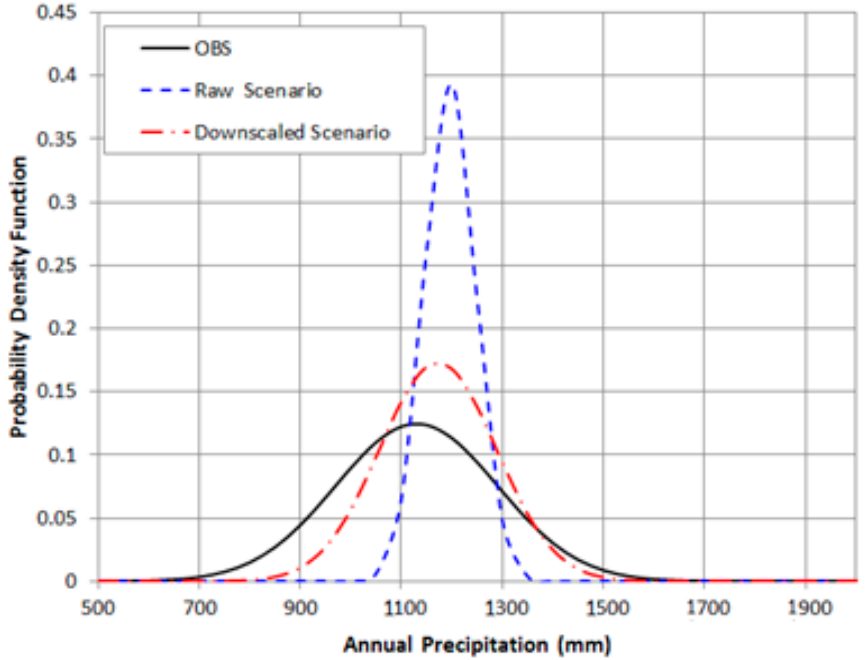
Figure 6. Observation and probability density functions of before / after application of the spatial disaggregation with quantile delta mapping (SDQDM) (annual precipitation).